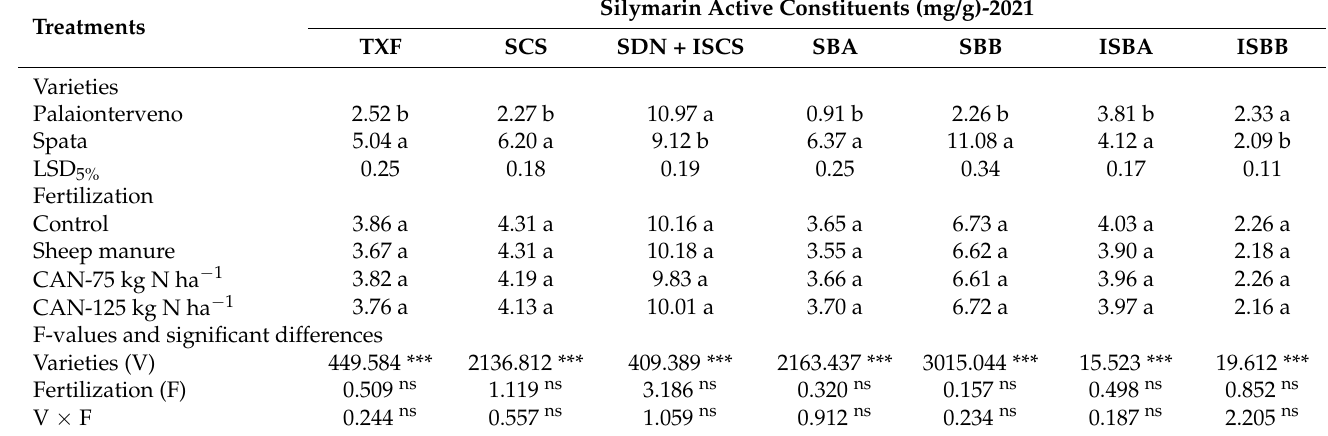
Table 10. Effects of two milk thistle varieties (Palaionterveno and Spata) and fertilization regimes (sheep manure and inorganic fertilizer) on the content of silymarin active constituents in fruits of milk thistle in